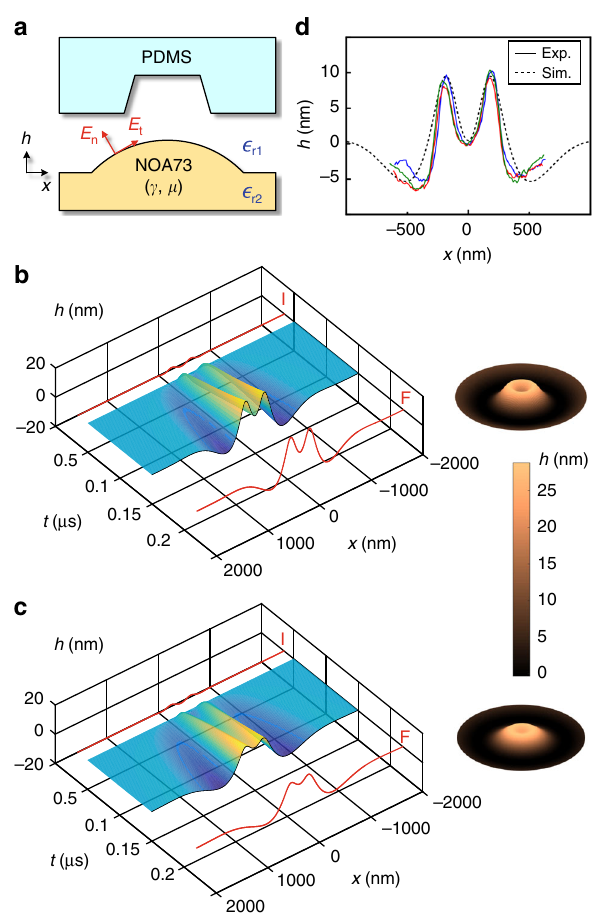
Fig. 5 Numerical modeling of the EHDL process. a The 2D model for the numerical EHDL simulation. b The simulated evolution of the nanovolcano structure. The inset shows the revolved version of the fi nal pro fi le (marked as “ F ” ). c The simulation result obtained after lowering the viscosity of NOA73. The nanocrater in b merged at the center to transform the nanovolcano into a nanocone. d The simulation (dotted line) and experimental (solid lines) results exhibit good